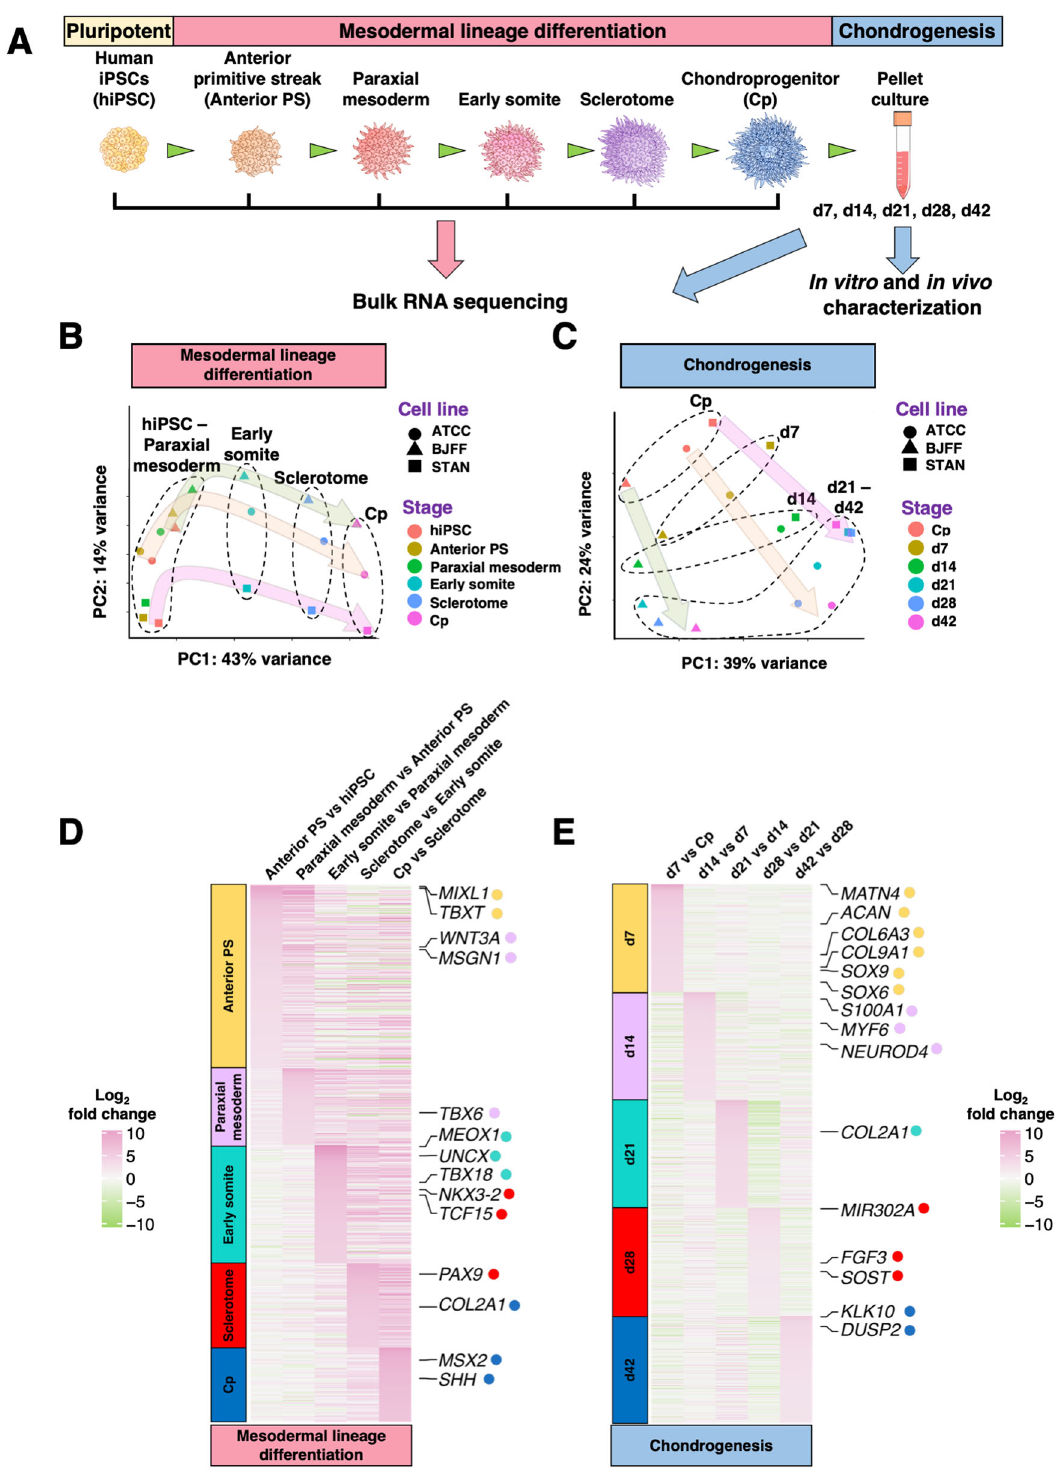
Fig. 1 DEGs of mesodermal and chondrogenic differentiation of three hiPSC lines by bulk RNA-seq. A Schematic of the chondrogenic differentiation protocol for hiPSCs. B , C PCA indicates that three unique hiPSC lines followed similar differentiation trajectories. D , E DEGs averaged from three unique hiPSC lines at each stage of differentiation, respectively. Each column of the heatmap represents a comparison between two stages/time points, and each gene presented was assigned a colored dot (following the gene label). The color of the dot matches the color of the timepoint label on the left side of the heatmap. When the color of a gene label and a timepoint label match, that gene was signi fi cantly upregulated at the corresponding time